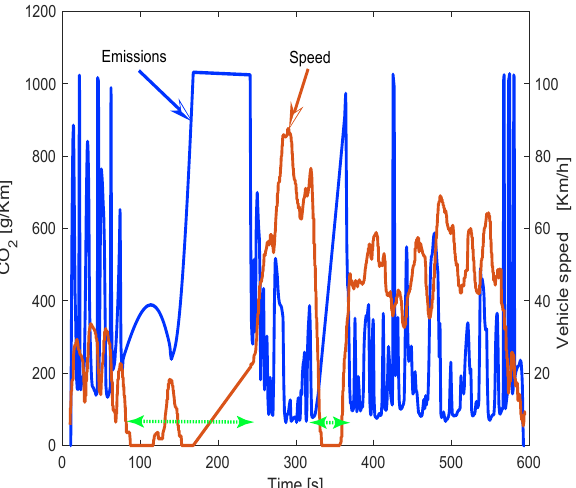
Figure 12. CO 2 emissions with respect to the vehicle speed. Note that lower than 20 km/h (marked by the green arrows), the CO 2 emissions per kilometer are drastically increased because the vehicle is liberating pollutants even the car is in idling stops.